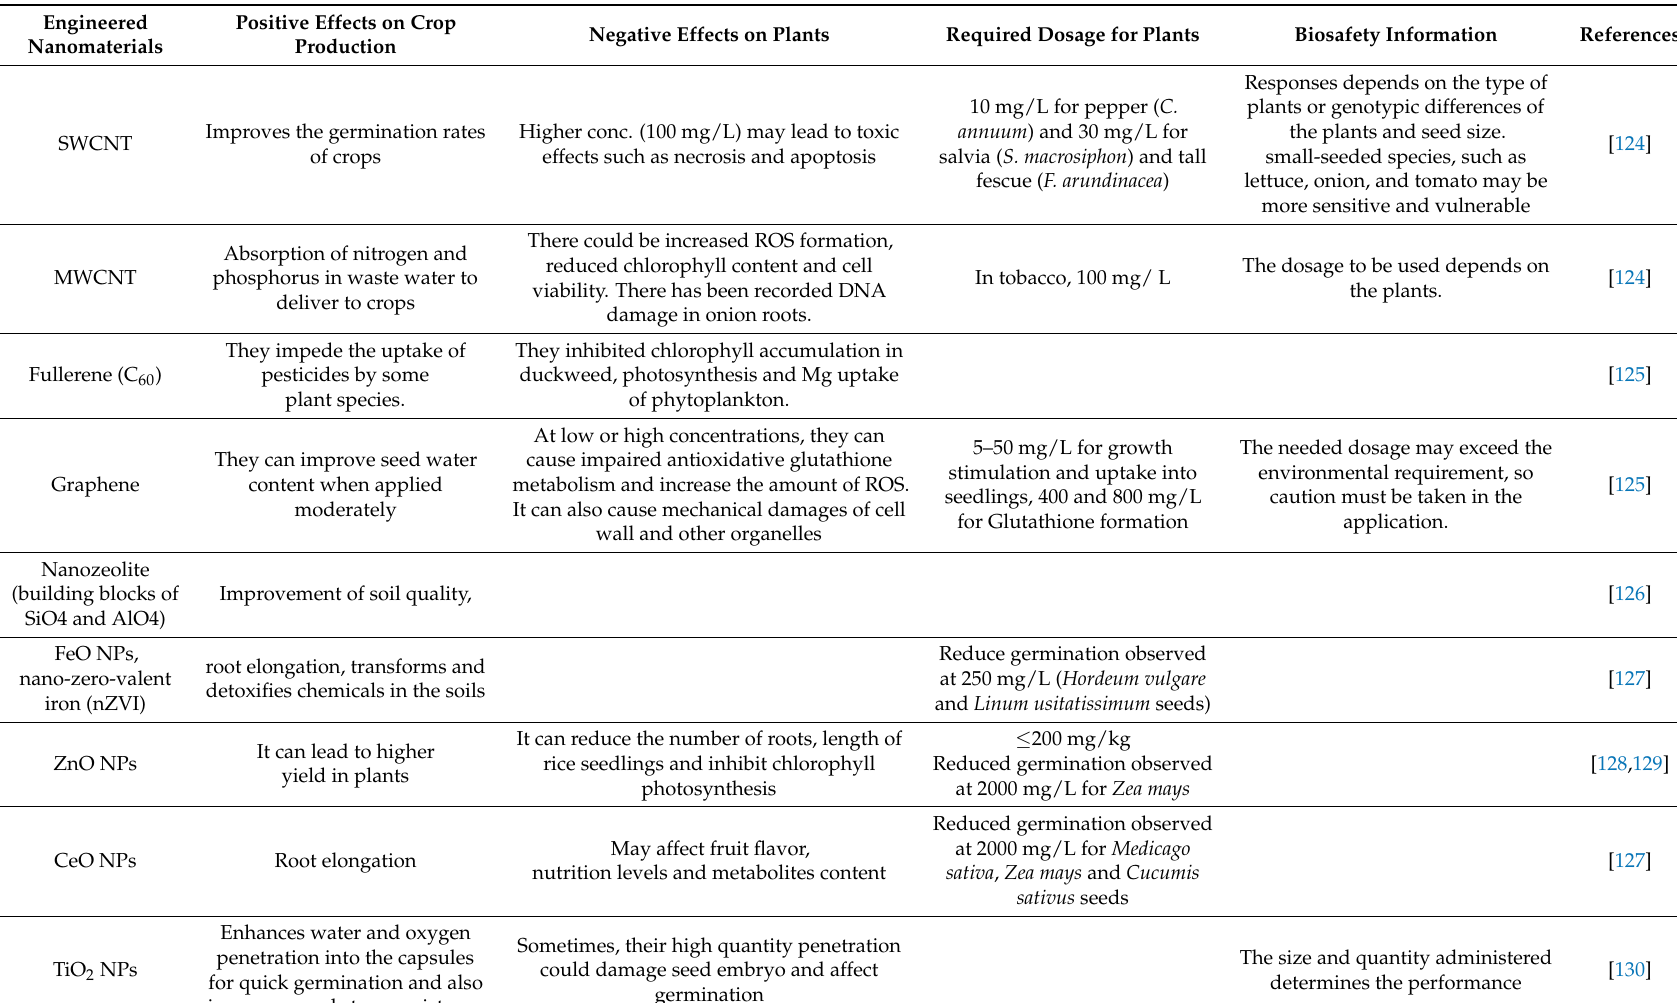
Table 3. Effects of some of the engineered nanomaterials on agricultural